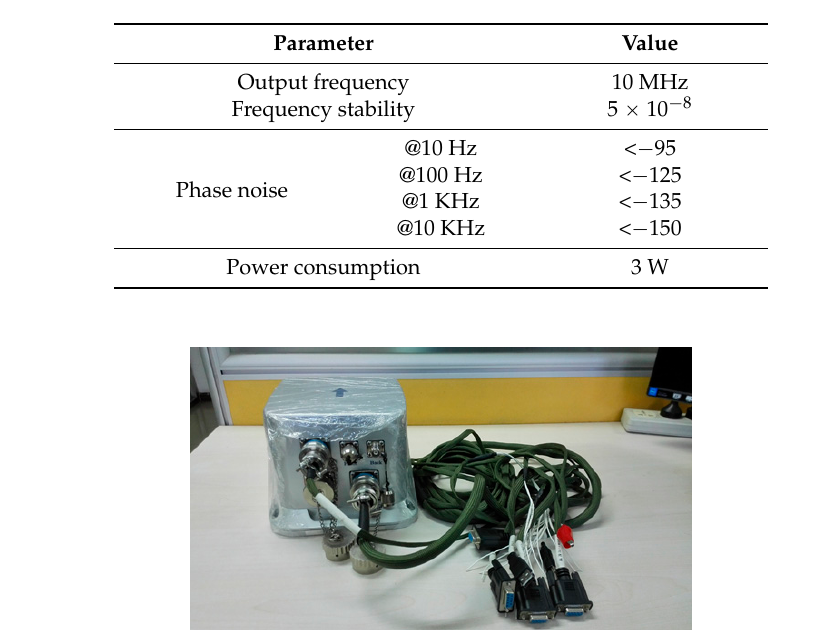
Table 4. Main parameters of OCXO.